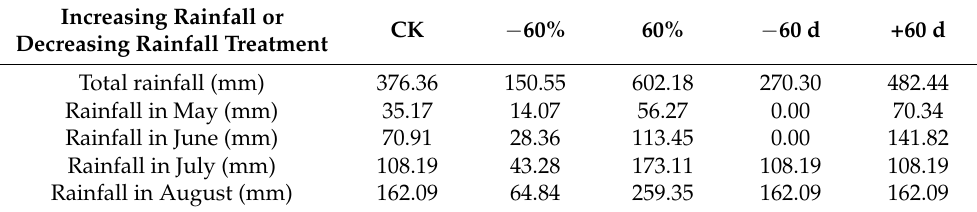
Table 1. Total rainfall and monthly rainfall during the 2018 growing season.